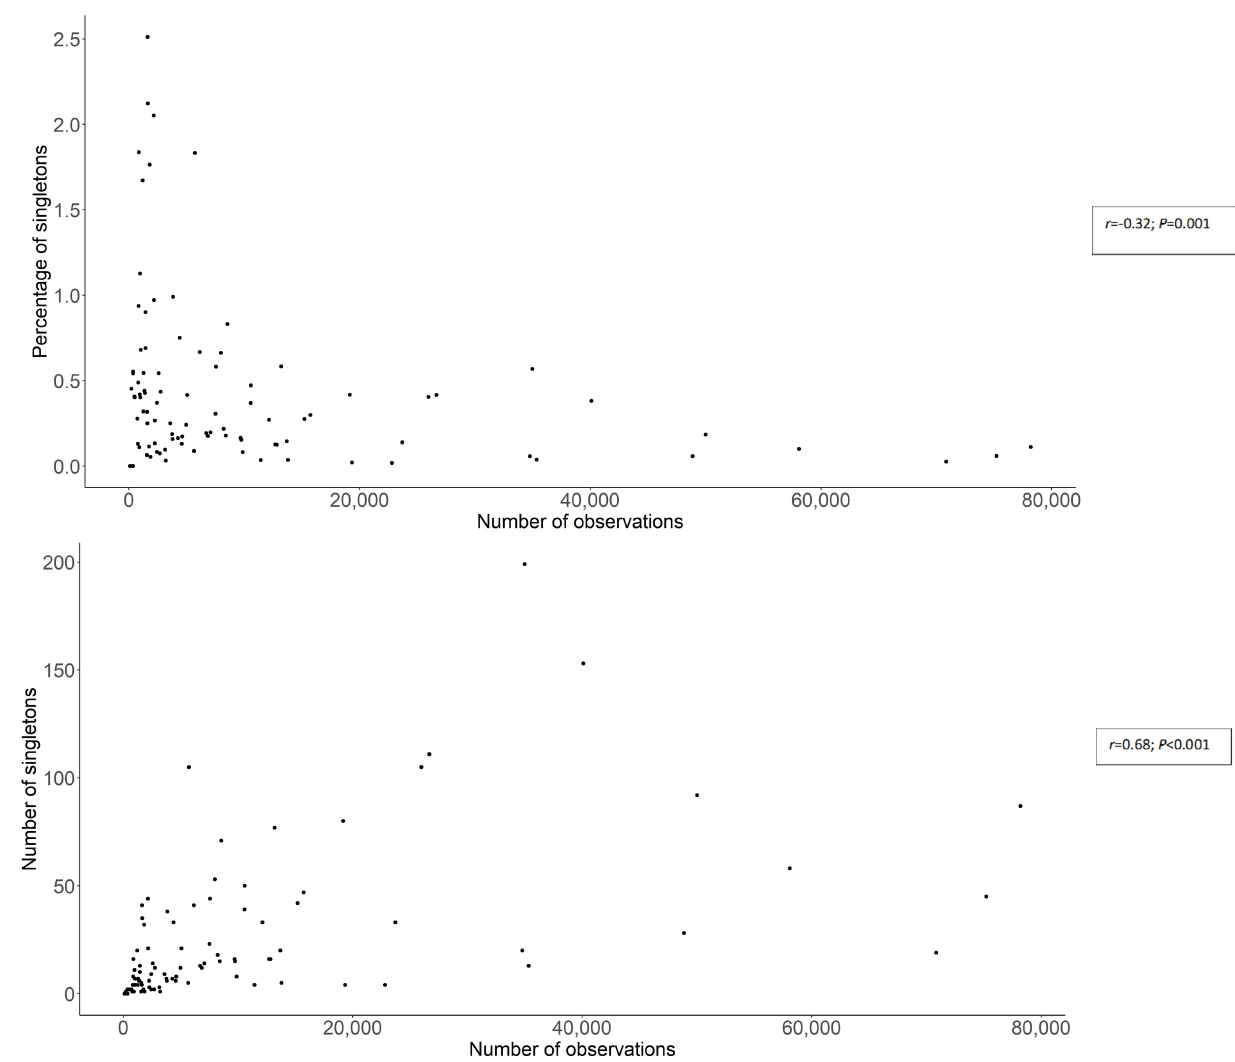
Figure 7. Correlation between the number of records in FongiBase in the 96 French departments and ( A ) the proportion of taxa represented by one record (singletons) and ( B ) the number of singletons, with the significance of Spearman correlation